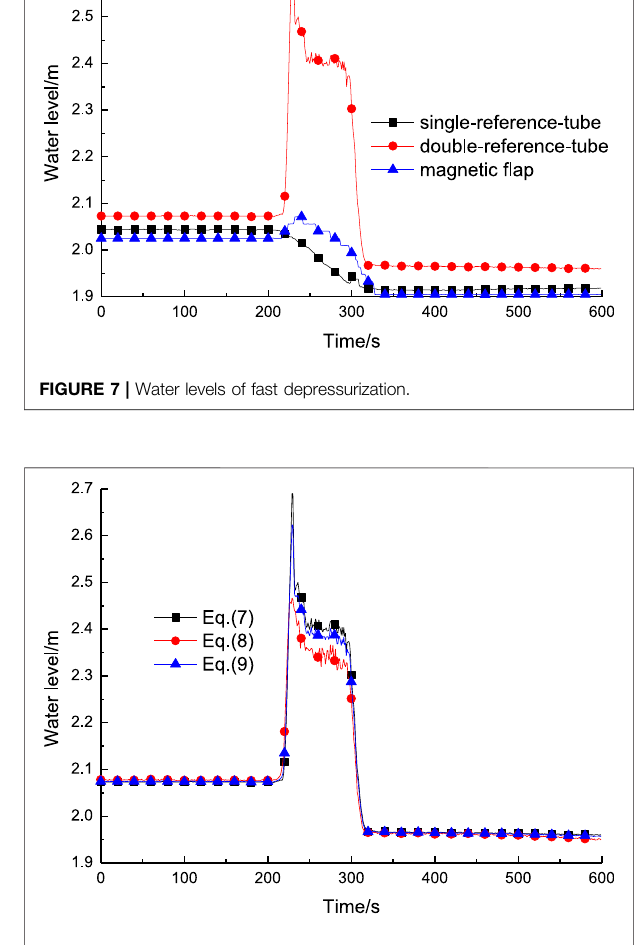
FIGURE 8 | Three channels of fast depressurization.